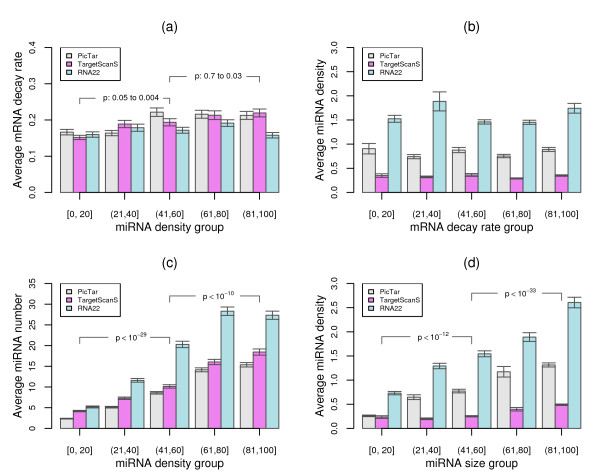
Relationship between miRNA density, mRNA decay rate, and the number of miRNA binding sites. (a) Variation of mRNA decay rates for 5 miRNA density groups with increasing miRNA density. The degree of the increasing trend for mRNA decay rates along with the increasing miRNA density was estimated by Wilcoxon rank sum tests and depicted in p-values. (b) Variation of miRNA density for 5 mRNA decay rate groups with increasing decay rate values. (c) Variation of miRNA binding site number for 5 miRNA density groups with increasing density values. The degree of the increasing trend for miRNA binding site number along with the increasing miRNA density was estimated by Wilcoxon rank sum tests and depicted in p-values. (d) Variation of miRNA density for 5 miRNA binding site groups with increasing number of binding sites. The degree of the increasing trend for miRNA density along with the increasing number of miRNA binding sites was estimated by Wilcoxon rank sum tests and depicted in p-values.